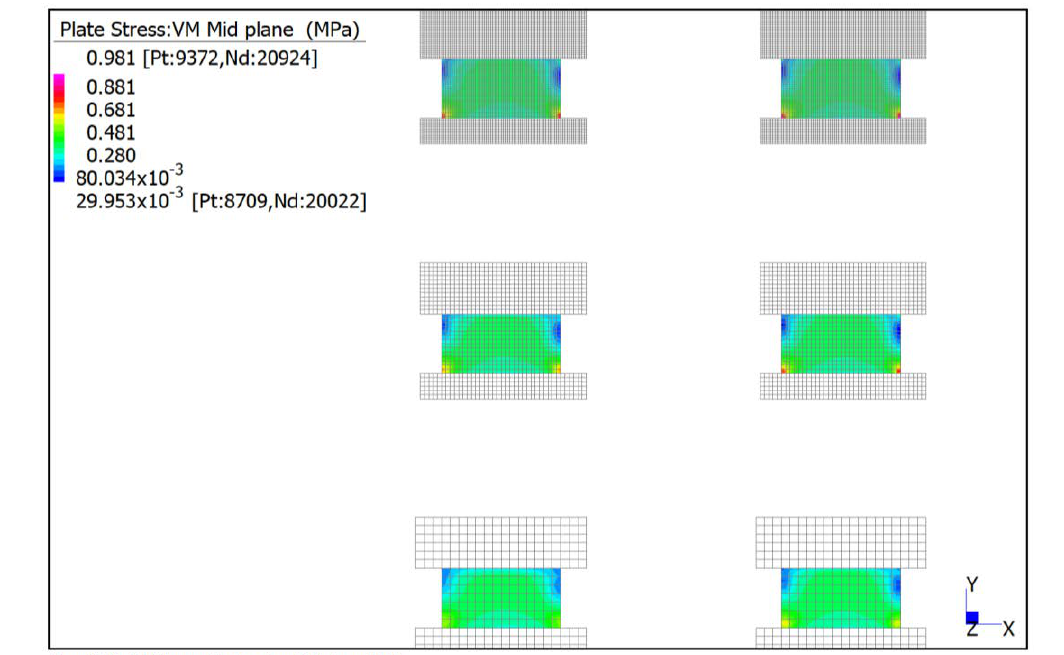
Fig. 15 Mesh convergence study Silicone Stress left 4 Node linear right 8 Node quadratic element, bottom 1mm mesh, middle 0.5mm and top 0.25mm mesh. Comparative study was carried out where structural silicone was modelled with selected material models. All material models were extracted from the published literature related to the behavior of the hyper-elastic materials , [2], [3], [4], [5], [6], [7], . Numerous recommendations were obtained during our literature review.